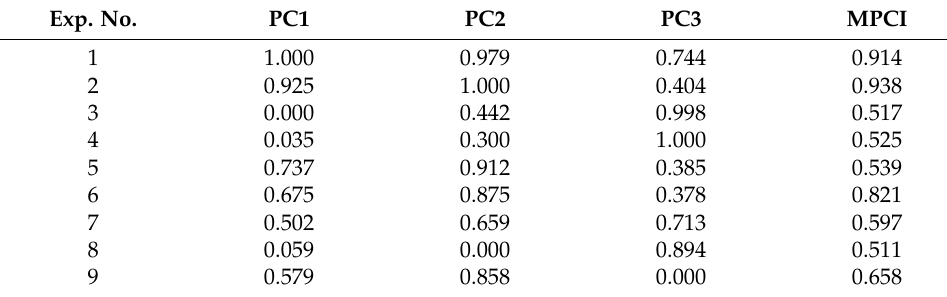
Table 6. Results of the MPCI for the Taguchi experiments.